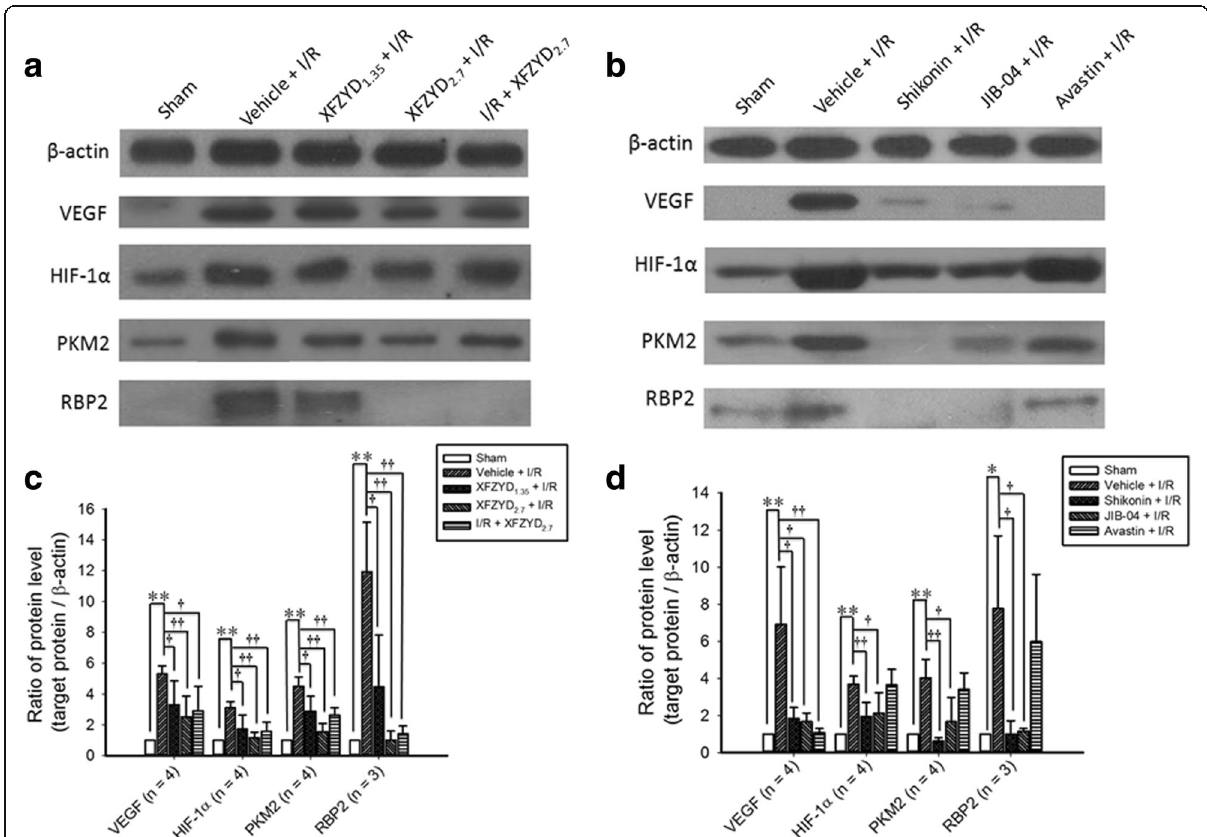
Fig. 8 The ratios of the protein concentrations of VEGF, HIF-1 α , PKM2 and RBP2 relative to β -Actin. a and b showed the Western blotting for expressions of β -actin, VEGF, HIF-1 α , PKM2 and RBP2. In figure a, Lane 1 is a retina that received the sham procedure (Sham); Lane 2 is the vehicle-preadministered ischemic retina (Vehicle + I/R); Lanes 3 ~ 5 are from retinas that received ischemia plus reperfusion and were preadministrated with 1.35 g/kg/day XFZYD (XFZYD 1.35 + I/R), 2.7 g/kg/day XFZYD (XFZYD 2.7 + I/R) or postadministrated with 2.7 g/kg/day XFZYD (I/R + XFZYD 2.7 ). In figure b, Lane 1 is from a sham retina (Control); Lane 2 is the vehicle-preadministered ischemic retina (Vehicle + I/R); Lanes 3 ~ 5 are from retinas that received ischemia plus reperfusion and were preadministrated with 4 μ M Shikonin (PKM2 inhibitor), 10 μ M JIB-04 (RBP2 inhibitor) and 100 mg/4 ml Avastin (anti-VEGF). (c and d) showed the protein levels of VEGF ( n = 4), HIF-1 α ( n = 4), PKM2 ( n = 4) and